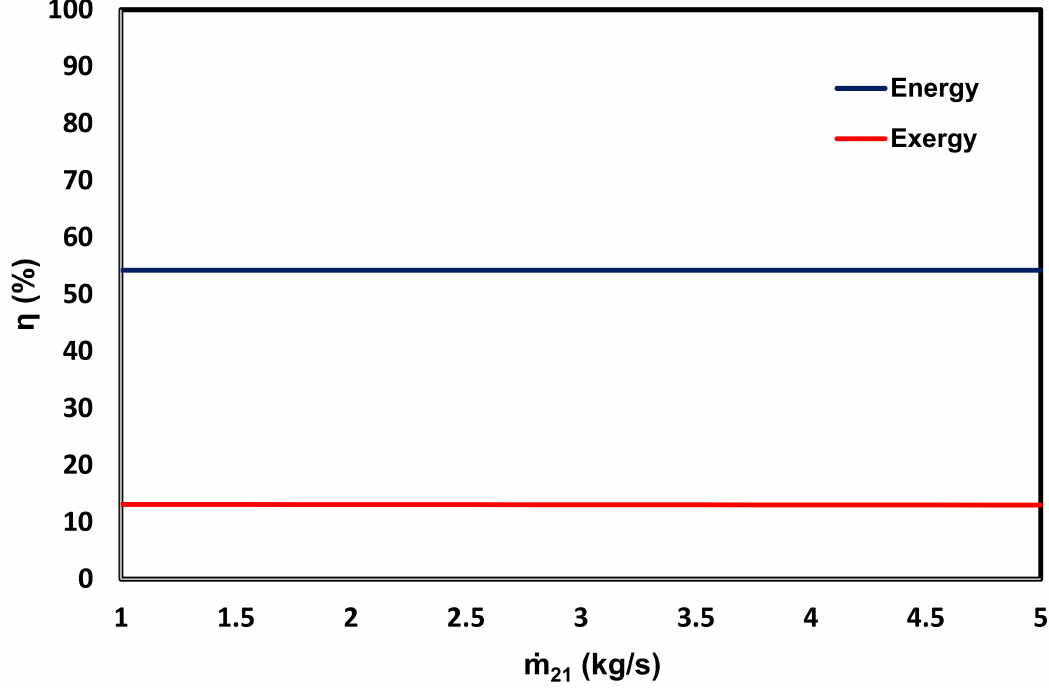
Figure 6. The system energy and exergy efficiencies versus seawater mass flow rate ( ˙m 21